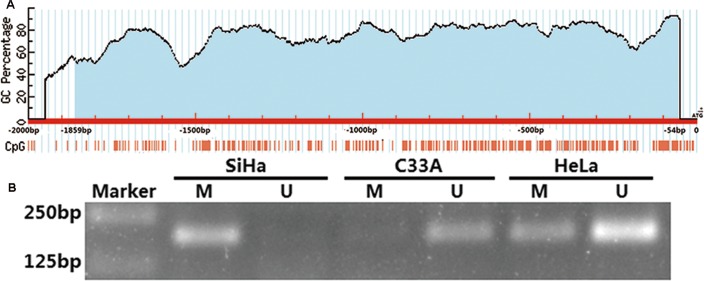
Detection of the methylation status in the promoter regions of SALL3 in cervical cancer cell lines.(A) Predicted CpG islands in the promoter region of SALL3. Numbers indicate the positions in bp relative to the transcription start site. The blue region represents the CpG islands and the red vertical bars are the CpG loci in these input sequences. (B) Detection of SALL3 methylation status by MSP in SiHa, C33A and HeLa cell lines. (M: methylated; U: unmethylated).